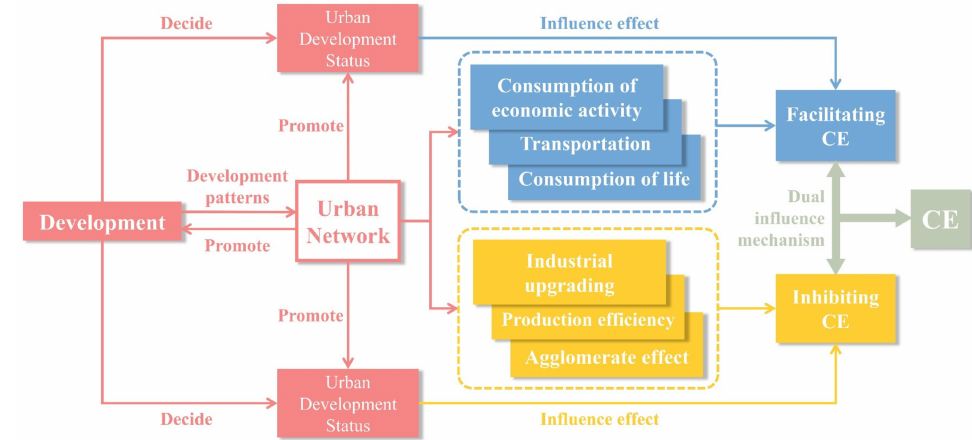
Figure 10. Diagram of two-sided impact mechanism of urban